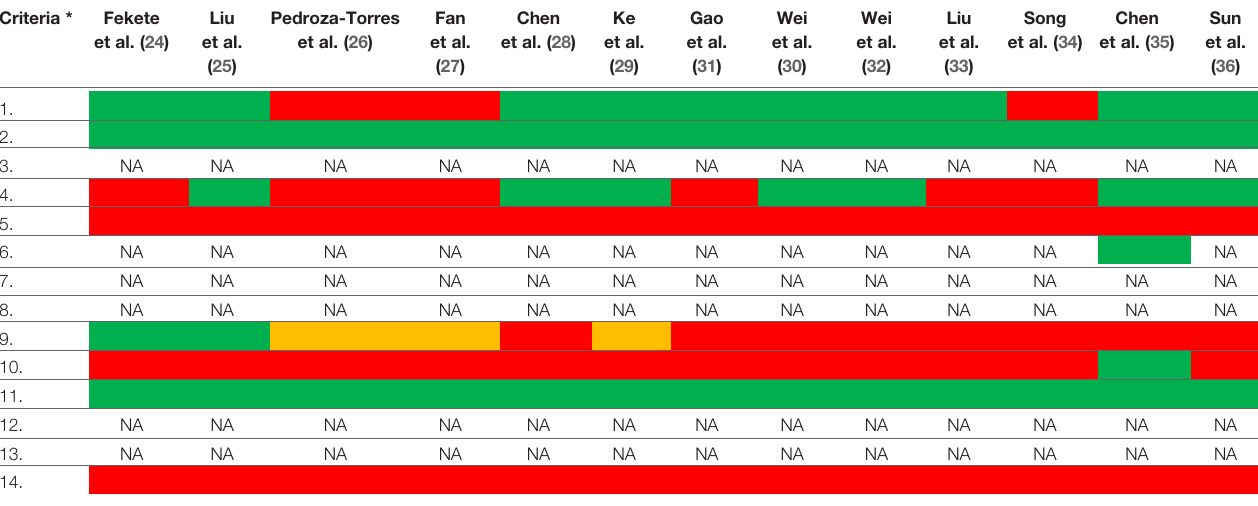
TABLE 3 | Quality assessment of the studies included in the present